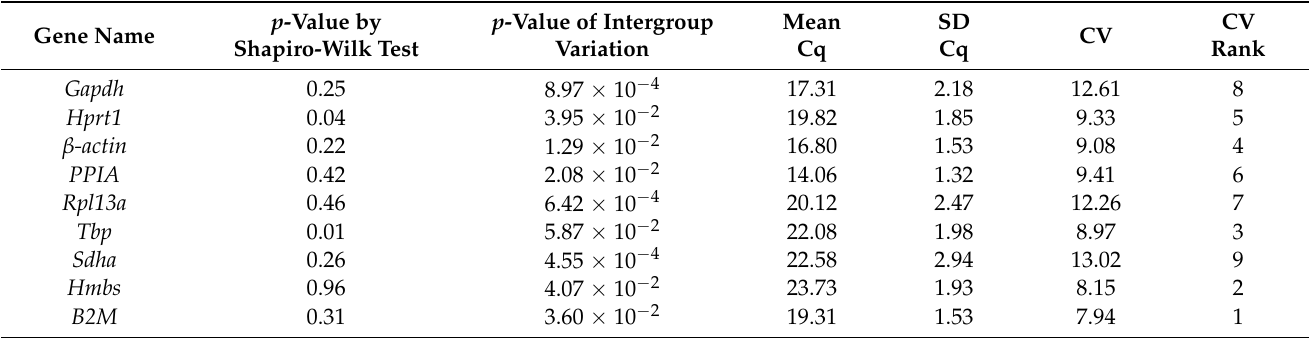
Table 8. Expression features in hypothalamus tissues at the developmental stage of PND 6w under different photoperiod conditions analyzed by SPSS.